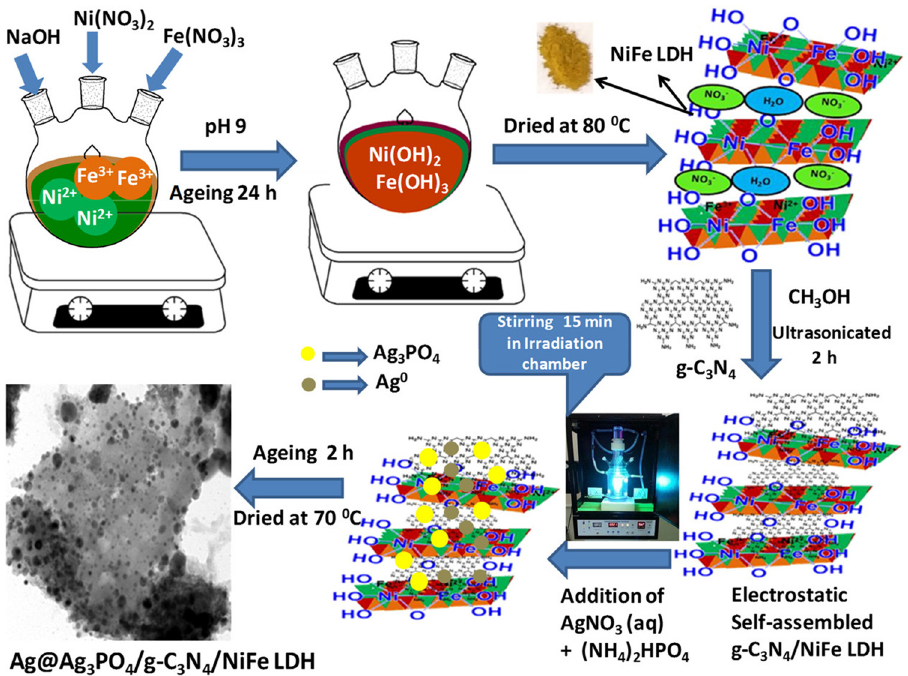
Figure 12: Synthetic steps of the heterostructure Ag@Ag 3 PO 4 /g - C 3 N 4 /NiFe - LDH nanocomposite. Reproduced with permission from ref. [ 45 ] ; copyright ( 2018 ) , American Chemical